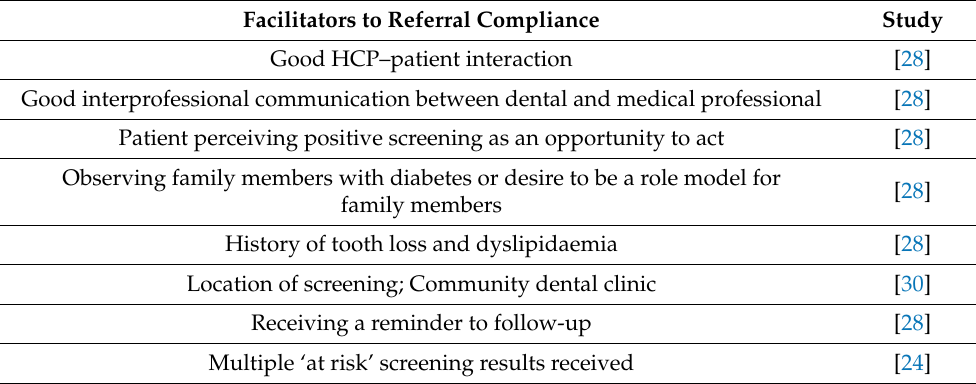
Table 3. Facilitators to participants’ adhering to referral recommendation of the